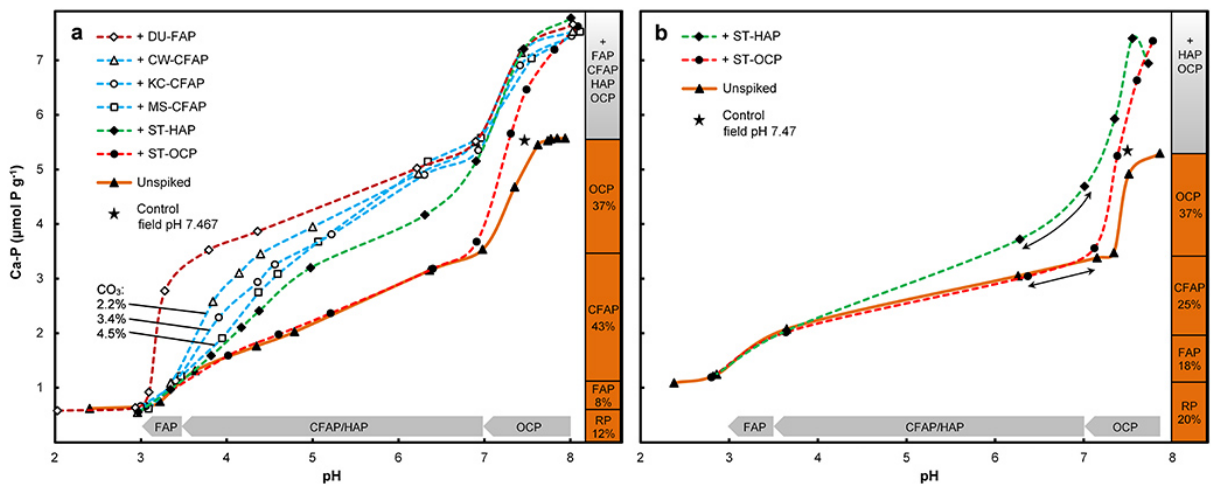
Figure 4. Differential Ca-P dissolution in sediment at varying pH as determined by subsample incubation of sediment (unspiked and with reference mineral additions) and subsequent fractionation (CONVEX method). (a) Standard addition experiments with natural and synthetic Ca-P using sediment from the Firth of Thames, New Zealand. (b) Standard addition experiments with synthetic Ca-P using sediment from the Saigon River delta, Vietnam (adapted from Oxmann et al., 2008). Columns indicate sedimentary Ca-P species composition in % (CFAP fraction may contain some HAP; see text) and standard additions. Note the greater extent of CFAP dissolution with increasing carbonate substitution. Note the increased slope of HAP addition for both sediments in the pH range 6.3–6.9, which was absent for unspiked sediment (arrows for visualization in b ) and other additions (cf. a ) except collophane (cf. Fig. 6). Control: fractionation without prior incubation. RP: residual P. See Table 1 for abbreviations and origins of added standard